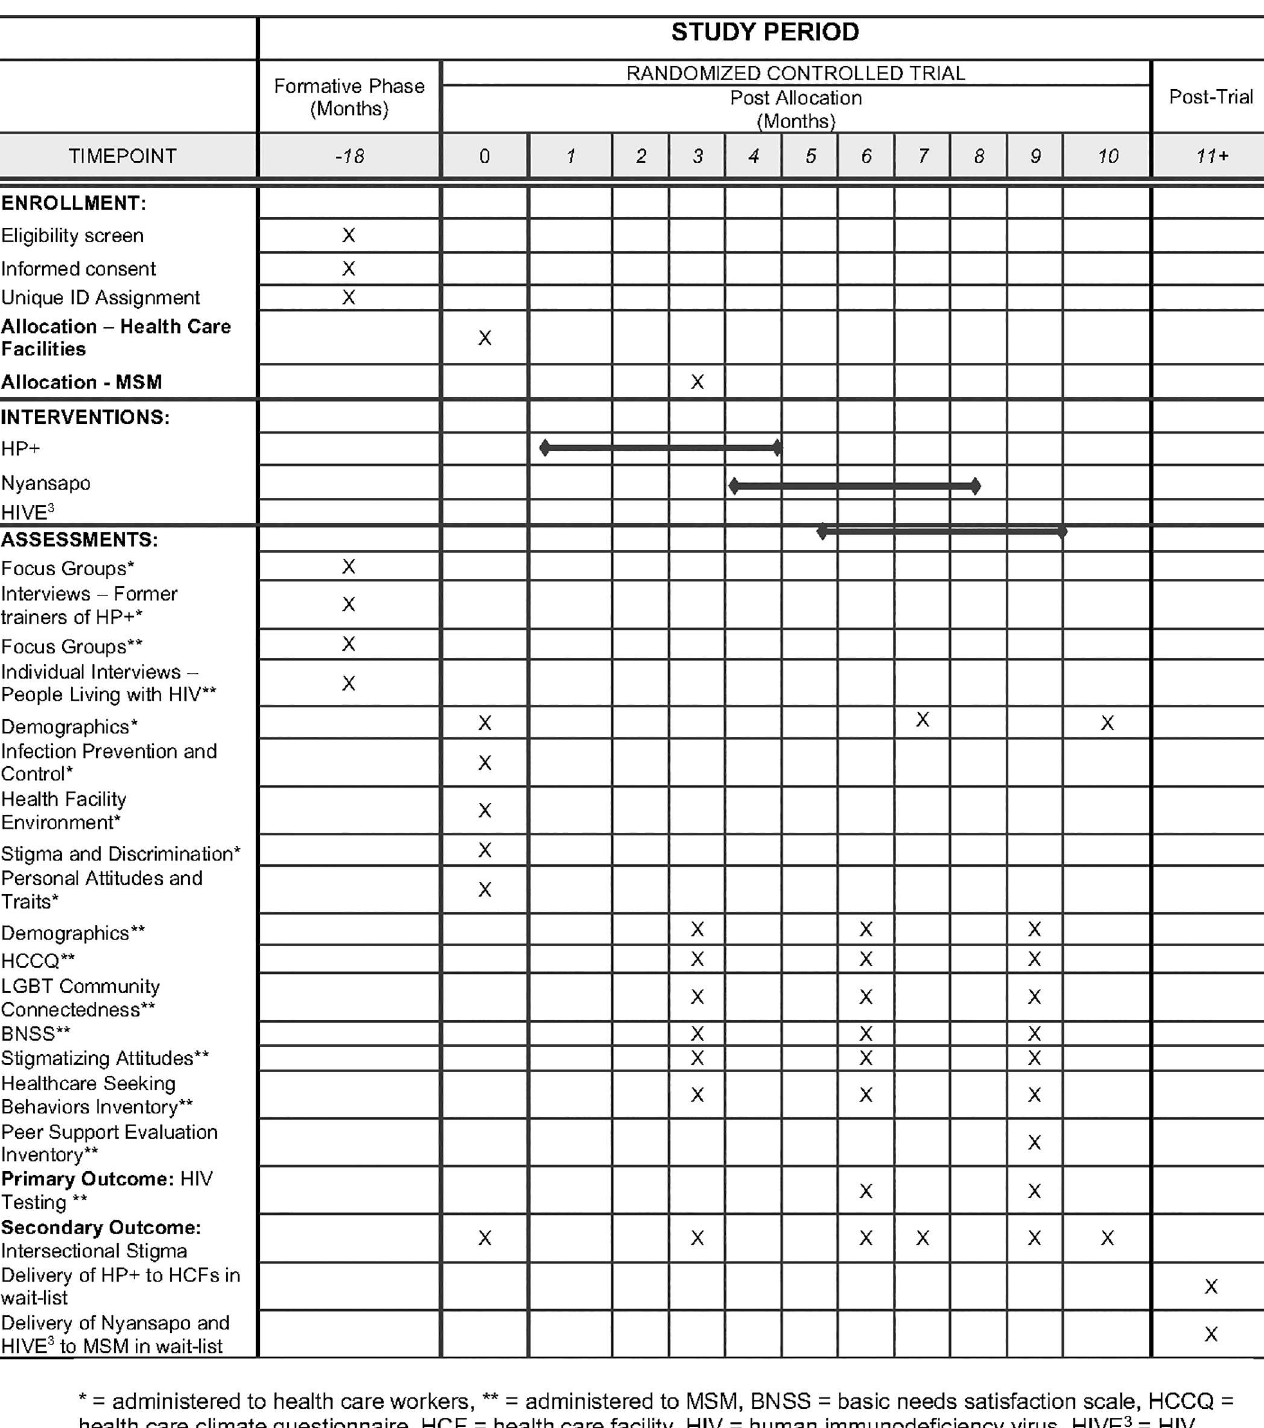
PLOS ONE | https://doi.org/10.1371/journal.pone.0259324 November29,